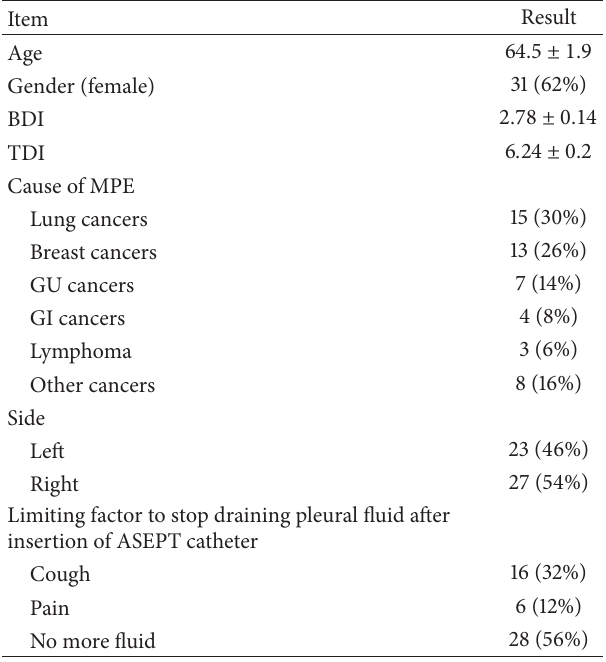
Table 1: Demographic information and clinical variables of the study.